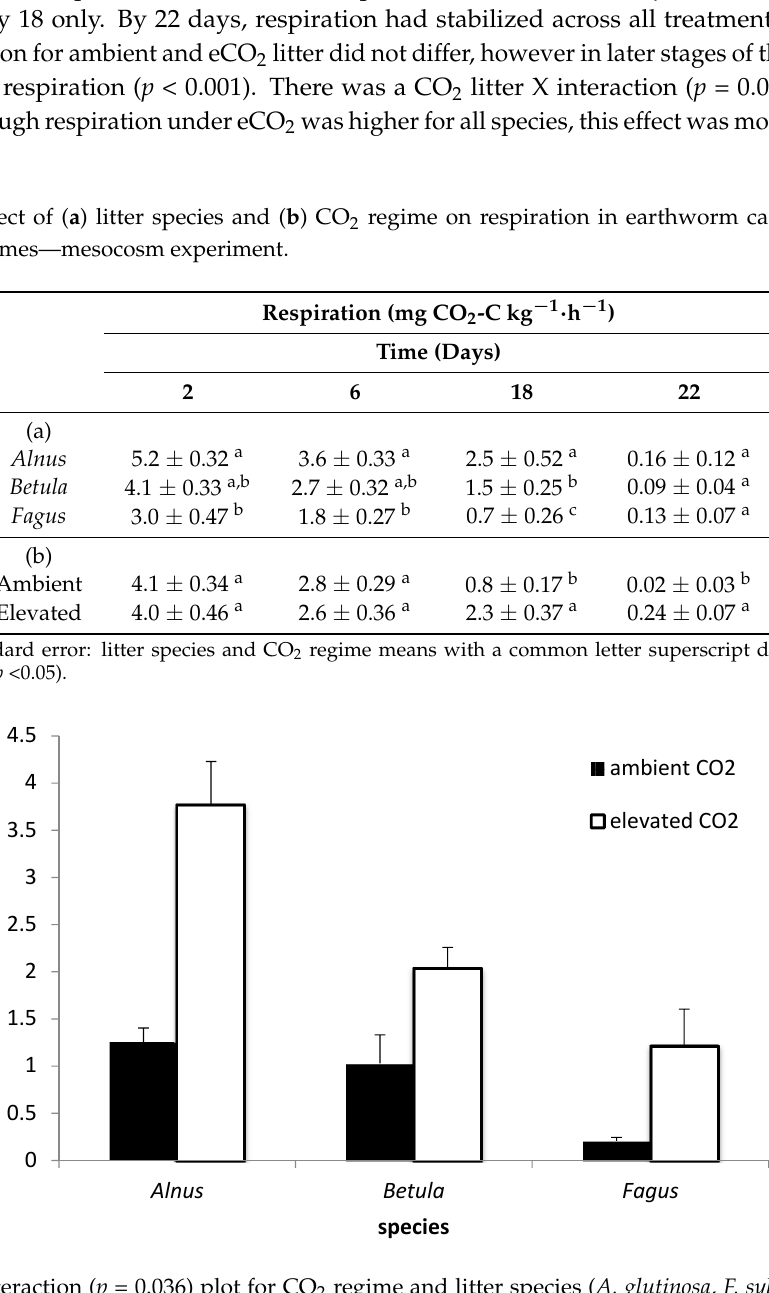
Figure 1. Interaction ( p = 0.036) plot for CO 2 regime and litter species ( A. glutinosa , F. sylvatica and B. pendula ) for respiration in earthworm casts at day 18 of incubation. Error bars represent standard errors ( n = 4).